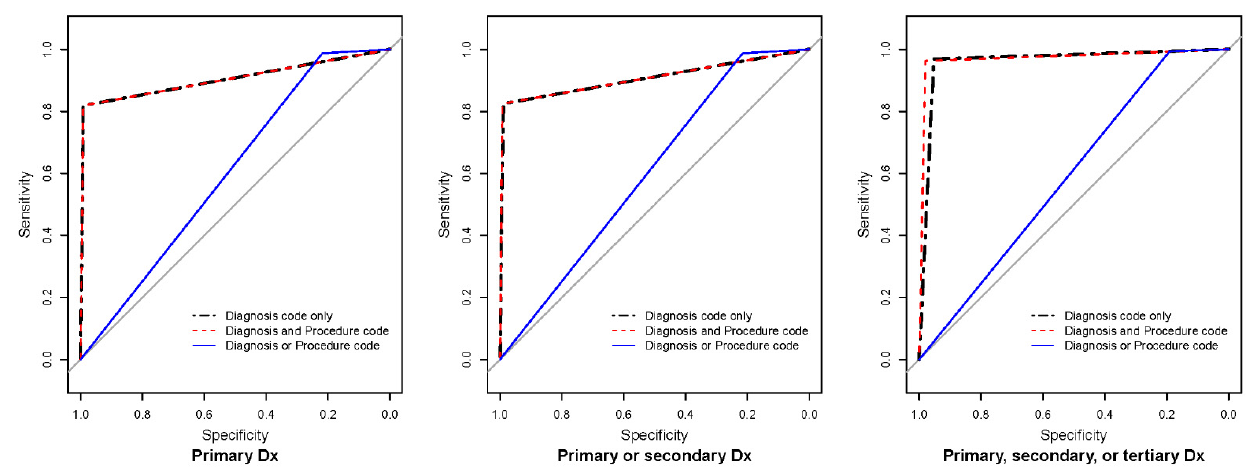
Figure 1. Receiver operator curves of the operational definition for osteoporotic hip fractures. Dx: diagnosis. Grey lines indicate chance diagonals (area under the curve = 0.5).